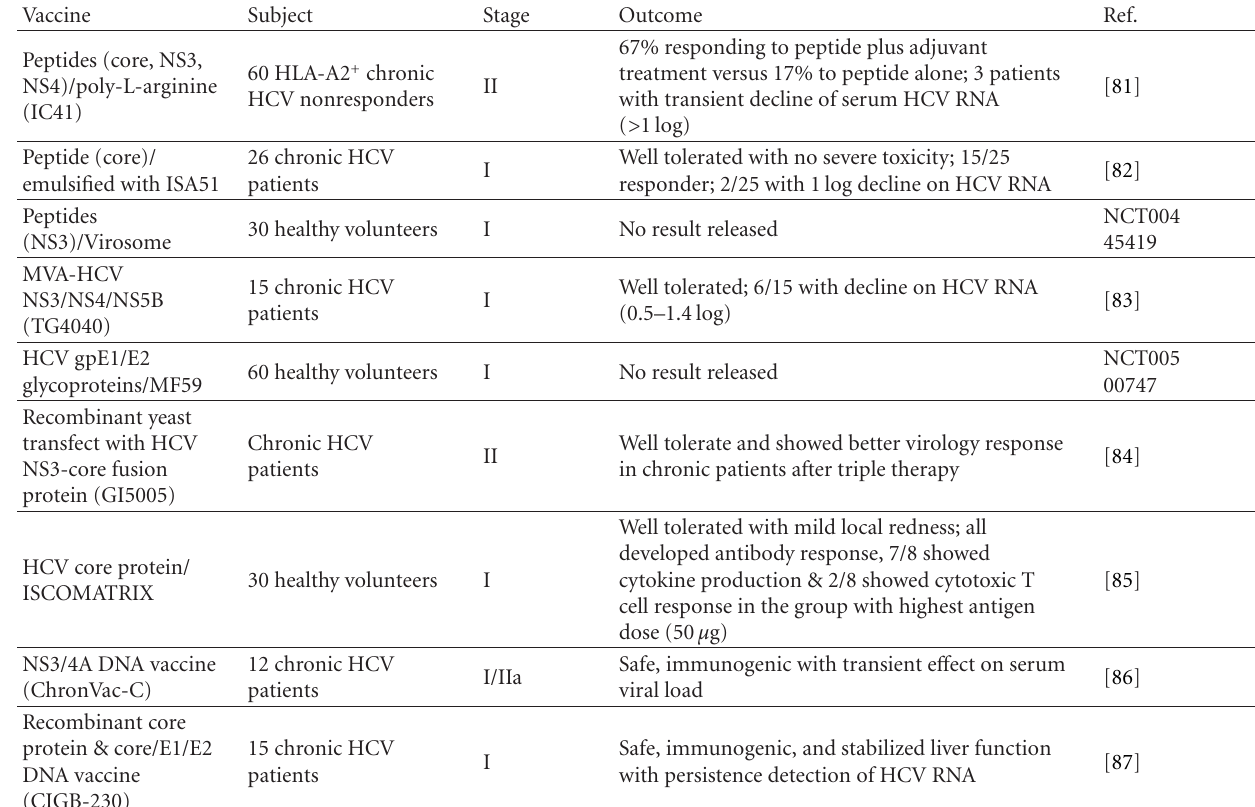
Table 3: Main vaccines in clinical trials for